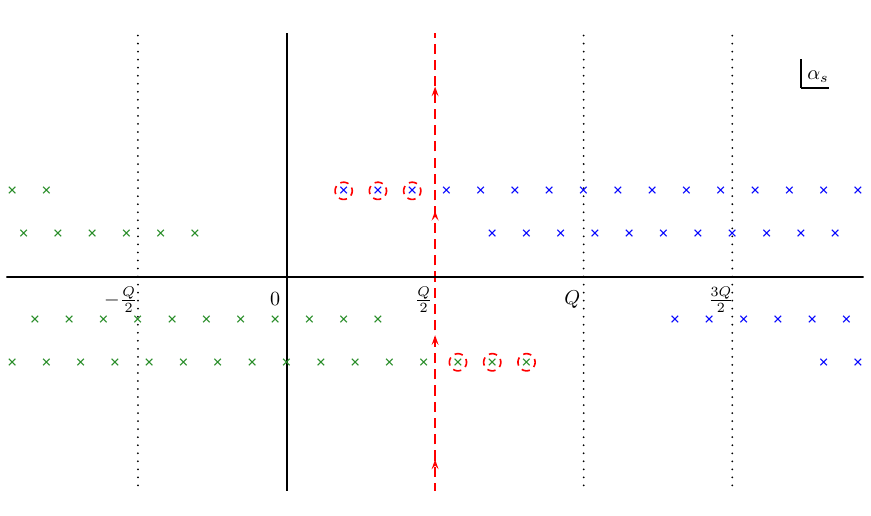
Figure 4 . Here we plot the poles of the fusion kernel as a function of (cid:11) s in the case of pairwise identical external operators and Re( (cid:11) 1 + (cid:11) 2 ) < Q , with 0 < b < 1. In this case, the poles at 2 (cid:11) s = (cid:11) 1 + (cid:11) 2 + mb < Q (and their re(cid:13)ections) cross the contour of integration and give discrete 2 residue contributions to the T-channel Virasoro block. Note that despite the fact that the external operators have weights lying in the discrete range rather than the continuum we have given (cid:11) i small imaginary parts for the purpose of